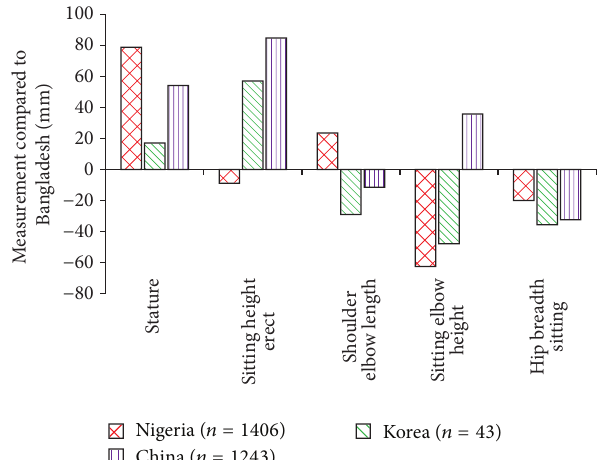
Figure 4: Differences of mean of selected body dimensions from different countries compared to Bangladesh.